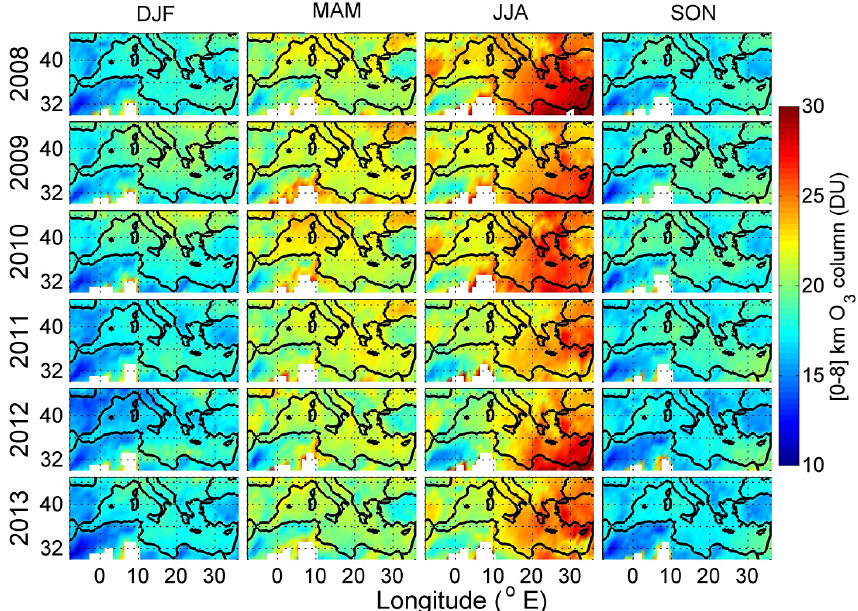
Figure 4. Six-year seasonal variation of [0–8]km integrated IASI O 3 column over the Mediterranean region for winter, spring, summer, and autumn. White pixels correspond to a filter applied to poor spectral fits because of emissivity issues in the FORLI radiative transfer above the Sahara.